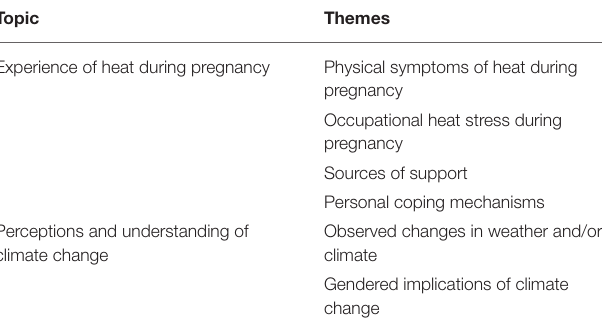
TABLE 1 | Research topics and